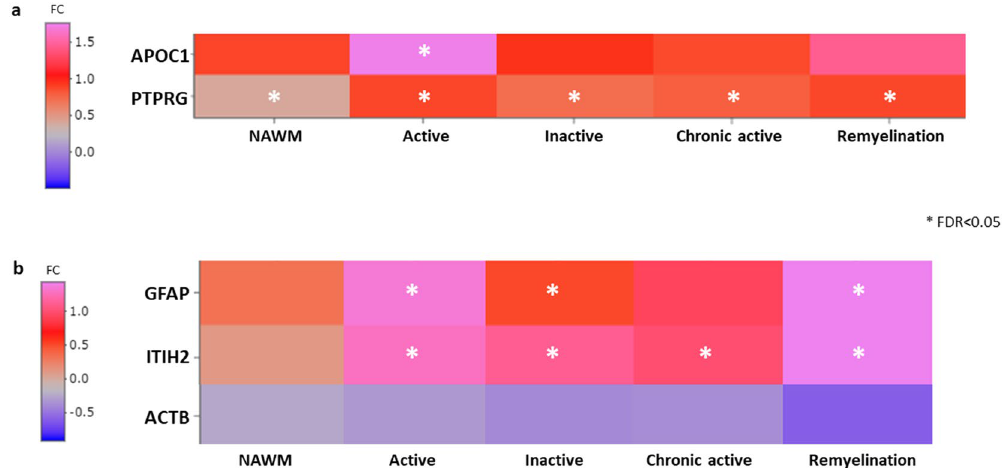
Figure 7. Expression of genes of upregulated disease-specific CSF proteins in transcriptomes of different MS brain lesions. The heatmaps show genes encoding the significantly altered CSF proteins that could be detected in different the brain lesions and normal-appearing white matter (NAWM) of MS. ( a ) The transcripts APOC1 and PTPRG encoding two MS-specific CSF proteins: apolipoprotein C-I and receptor-type tyrosine-protein phosphatase gamma. ( b ) The transcripts GFAP , ITH2 and ACTB encoding the NMOSD-specific CSF proteins: glial fibrillary acidic protein (GFAP), inter-alpha-trypsin inhibitor heavy chain H2, and actin cytoplasmic 1. Stars represent significantly differentially expressed genes (FDR < 0.05) in the MS lesions compared to non- neurological disease brains. Colour represents the log2fold change